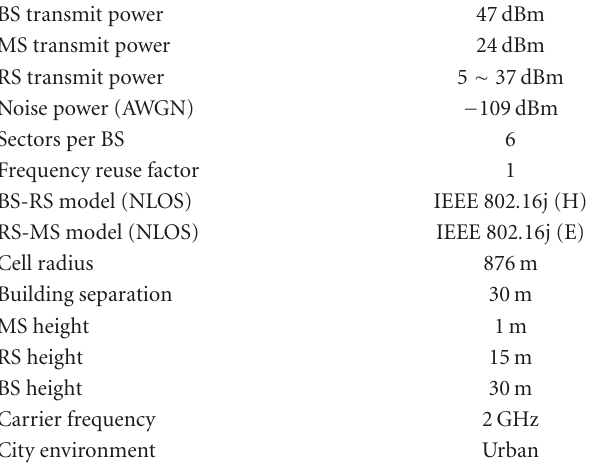
Table 1: Parameters for multi-cell